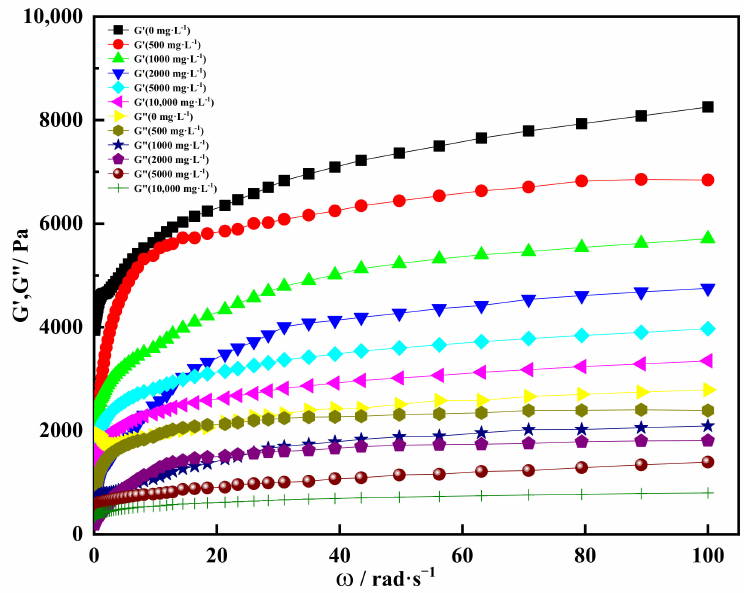
Figure 17. Storage modulus and loss modulus varied with angular frequency at different concentra- tions of divalent salt